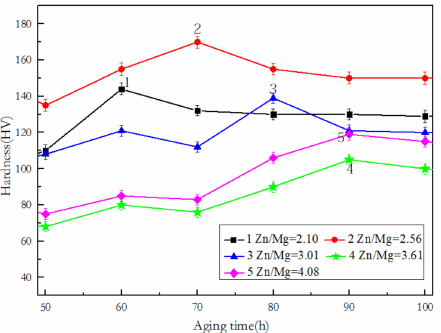
Figure 1. The age-hardness curves of the alloys during isothermal aging at 120 ◦ C.